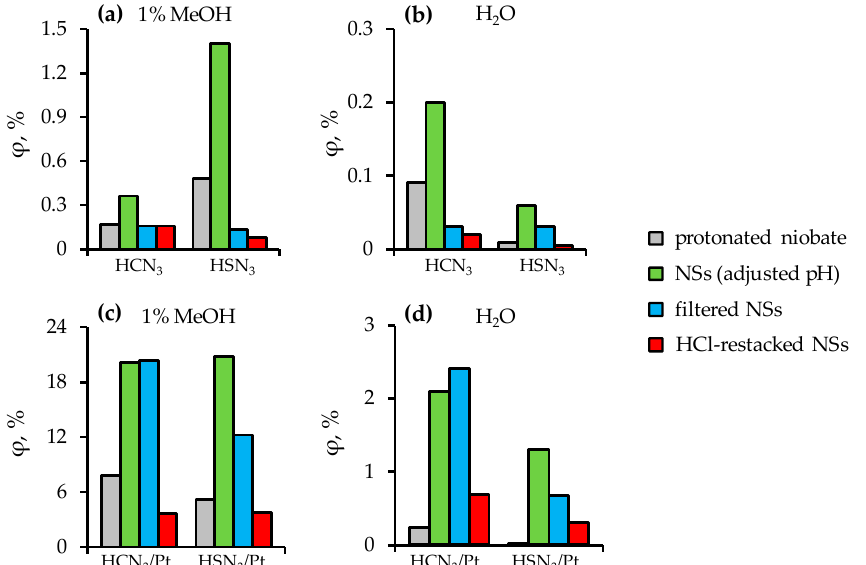
Figure 8. Comparison of apparent quantum efficiency of hydrogen generation from 1 mol.% aqueous methanol and water over the protonated niobates and their nanosheet-based photocatalysts in a bare state ( a , b ) and after surface platinization ( c , d ).